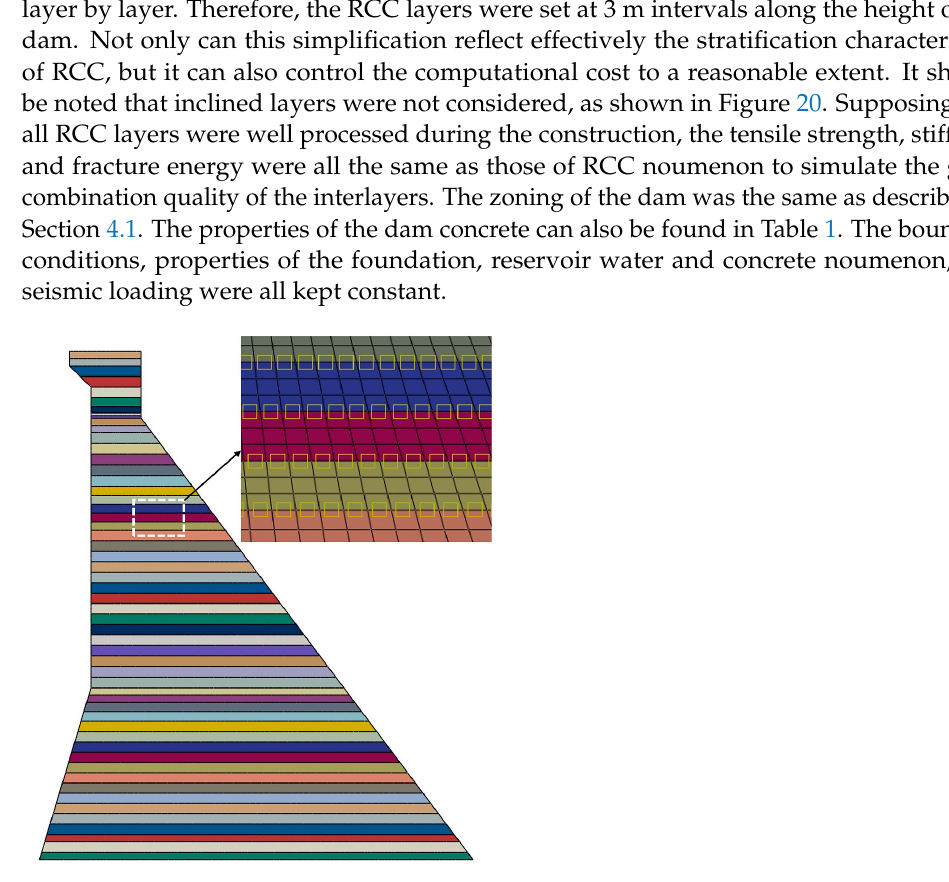
Figure 20. Schematic diagram of the dam with RCC layers every 3m along the dam by zero-thickness cohesive elements.